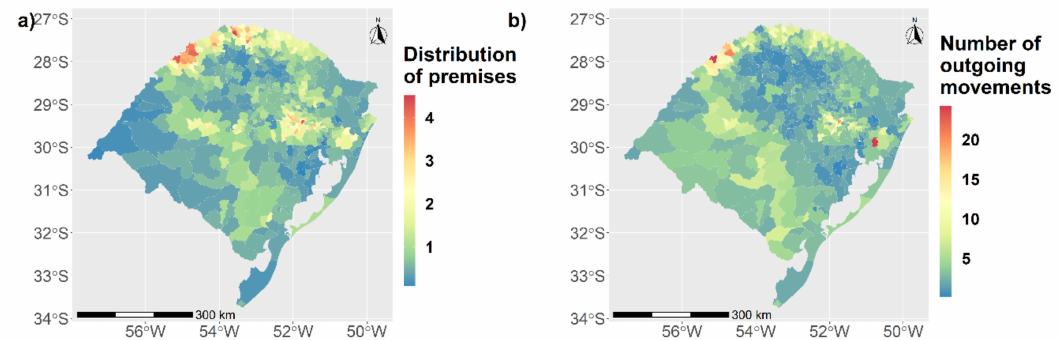
Figure 1. Spatial distribution of premises and animal movements in Rio Grande do Sul (RS) state. ( a ) Distribution of premises in km 2 by municipalities. ( b ) Number of outgoing movements in km 2 by municipalities.